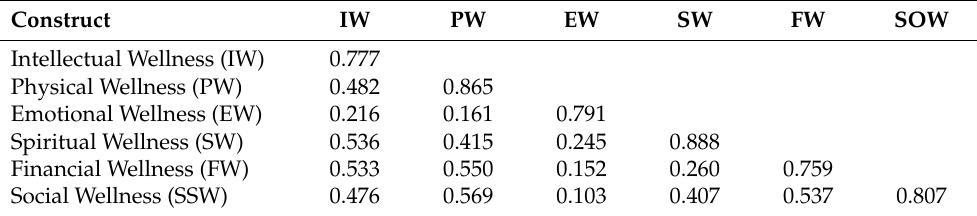
Table 2. Discriminant Validity.